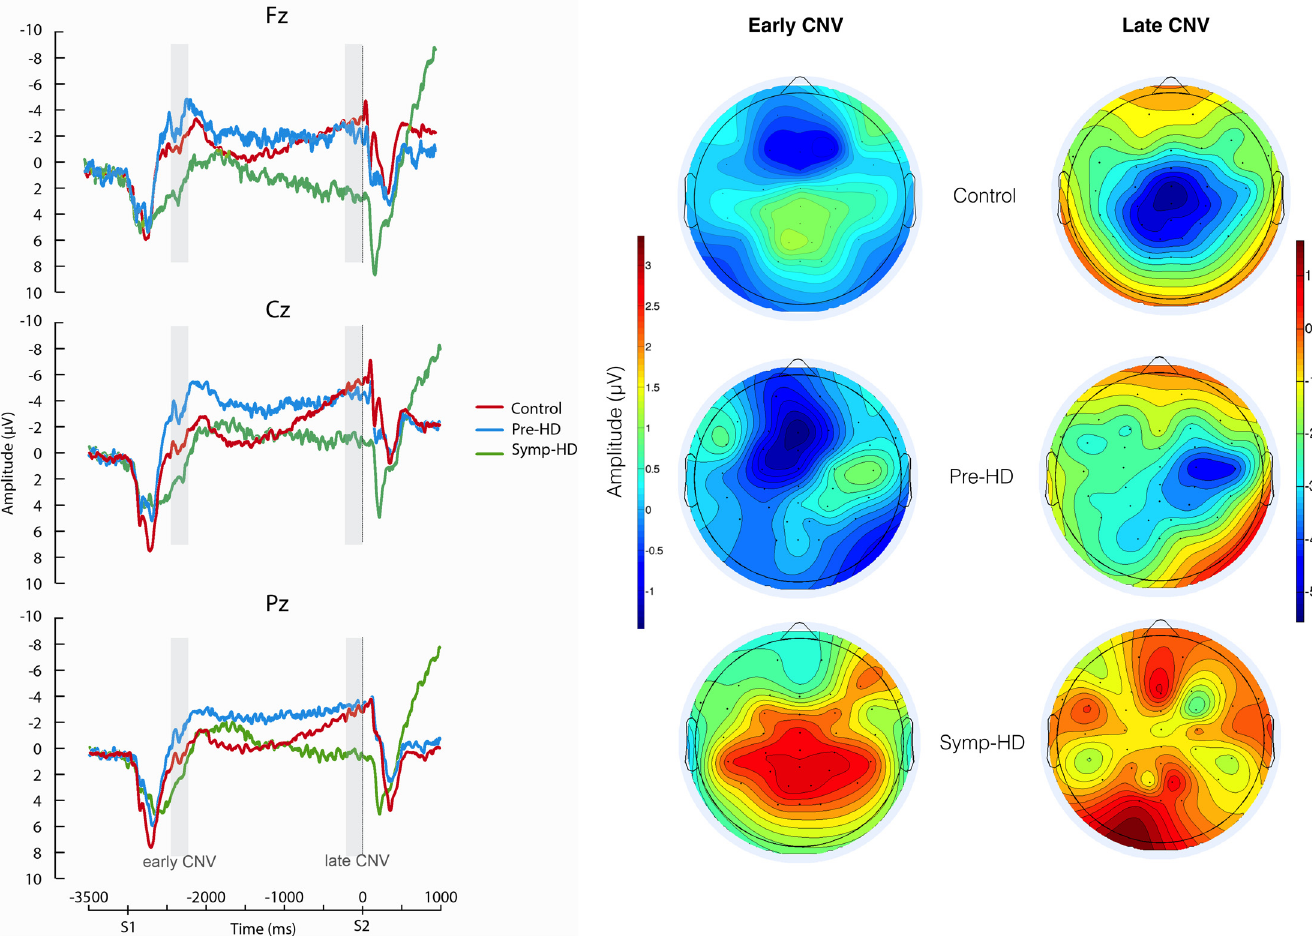
Fig 2. Sensorimotor Integration Task/CNV. Grand average Go/No-Go waveforms at Fz, Cz and Pz across subjects; S1 and S2 are the warning and stimulus onset times respectively. Scalp topography maps represent mean amplitude of the CNV at early and late periods by group. Early CNV refers to the period 550 – 750 ms following presentation of the warning light (stimulus 1); Late CNV refers to the period 200 ms prior to the onset of the Go/No-Go cue for button press (stimulus 2).